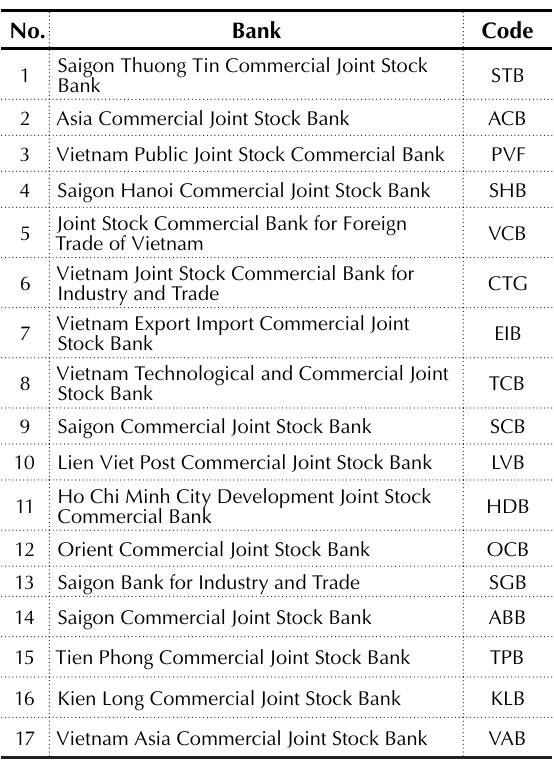
Table 1. Banks in the research sample No. Bank